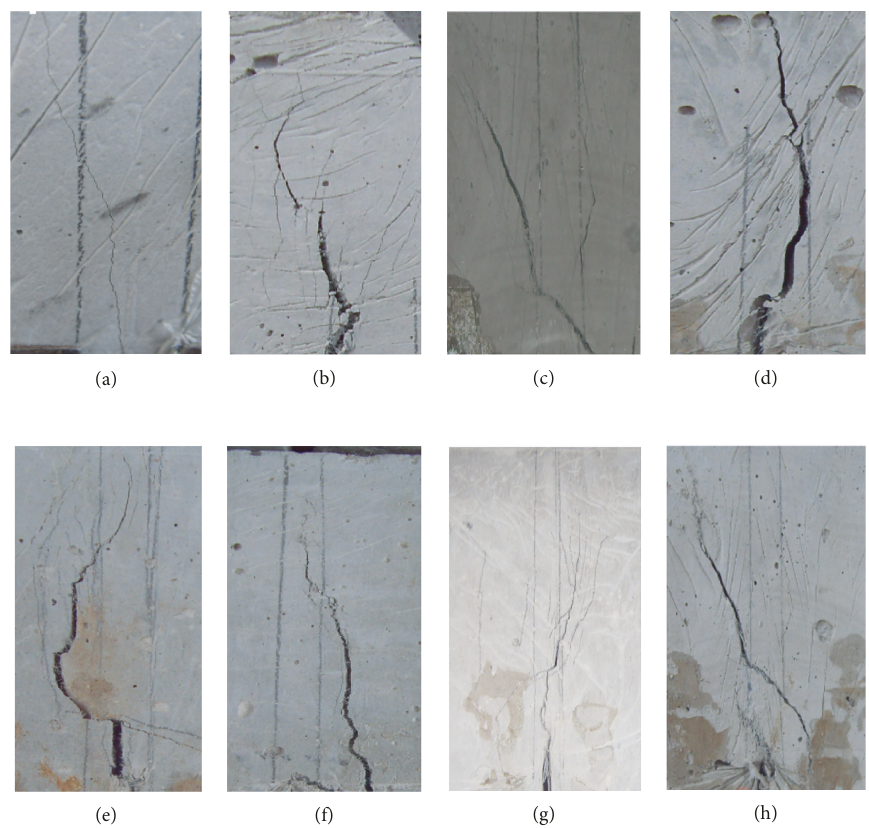
Figure 8: Side surfaces of ECC failure specimens under different stress levels. (a) Matrix. (b) S � 1. (c) S � 0.655. (d) S � 0.59. (e) S � 0.55.